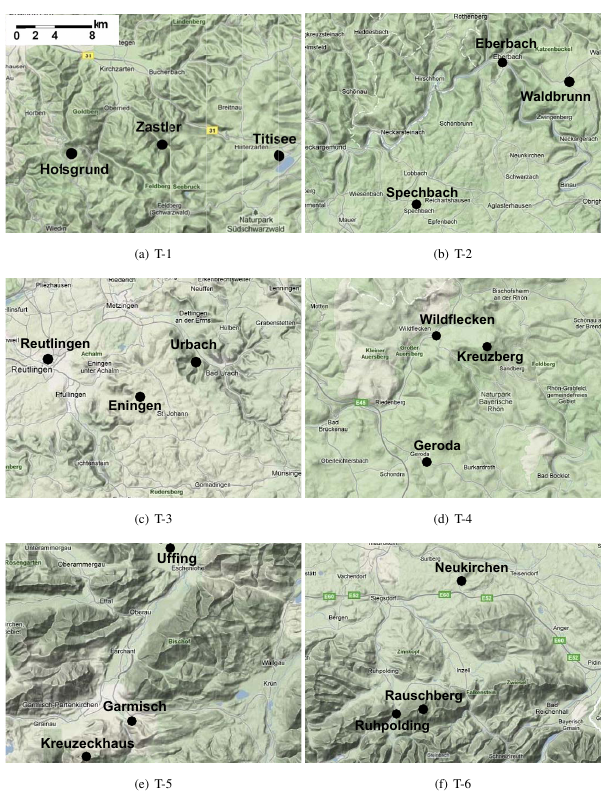
Fig.13. Detailedtopographyoftheselectedthestationgroups Fig. 13. Detailed topography of the selected the station